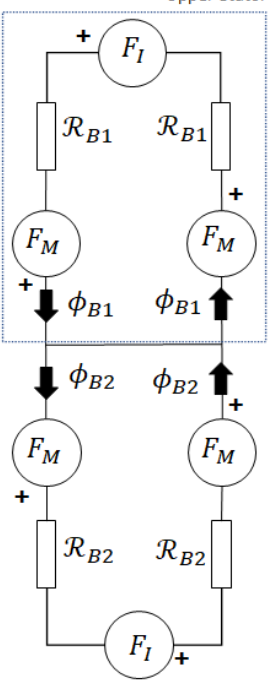
Figure 5. Simplified phase-B magnetic equivalent circuit for PM-LHRM .